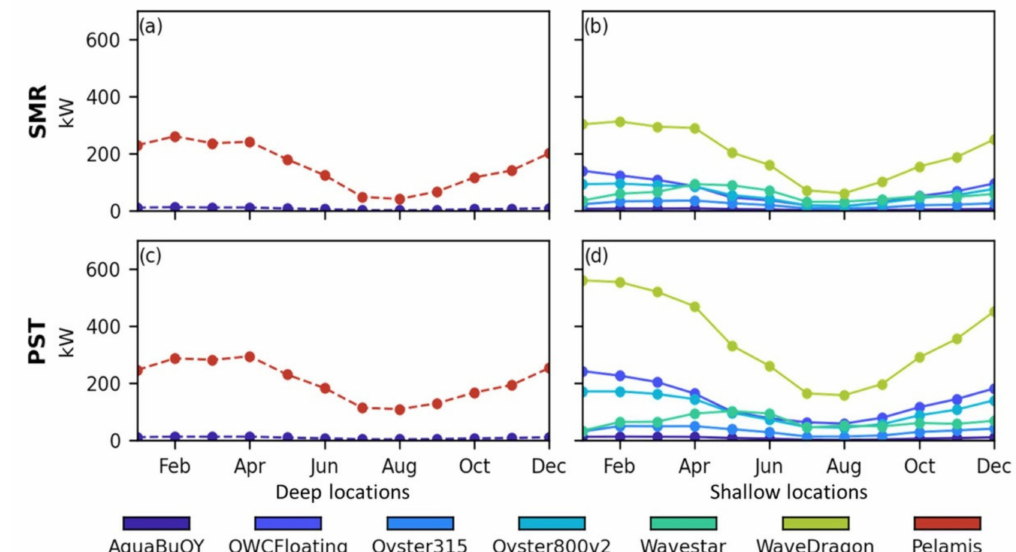
Figure 6. Monthly mean power harvested by the analyzed WECs at the deep ( a , c ) and shallow ( b , d ) locations of the PST ( c , d ) and SMR ( a , b )